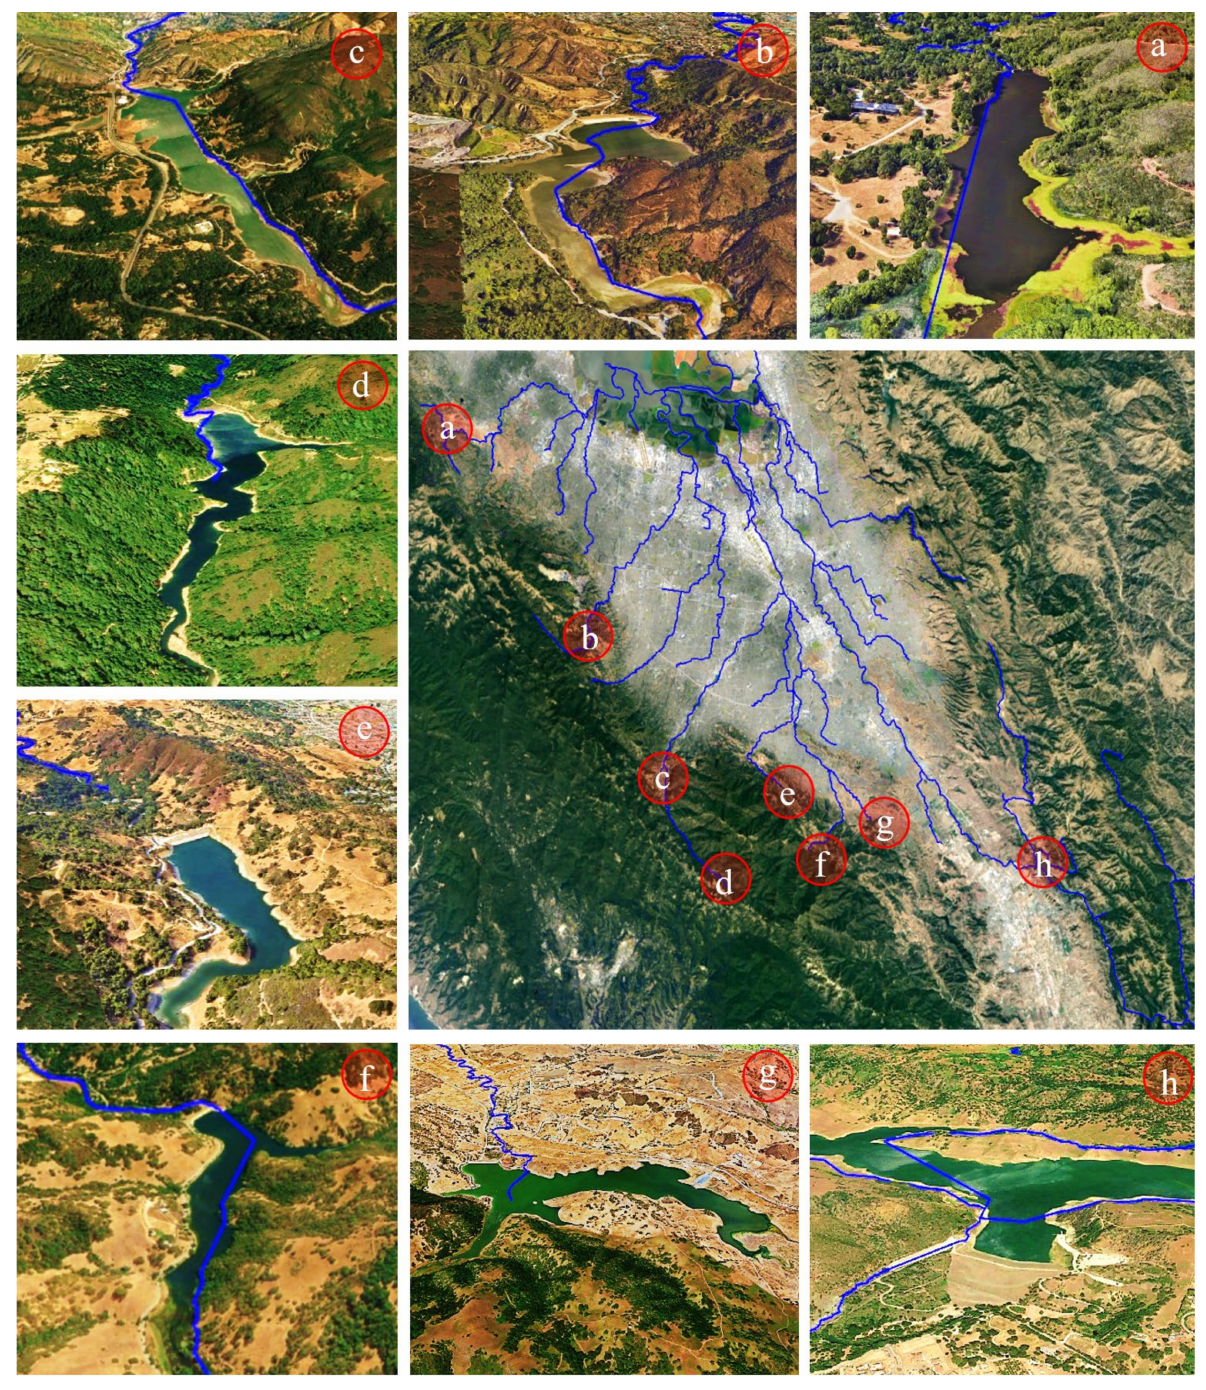
Figure 9. The main streams along with the location of the water control structures with respect to the Santa Clara